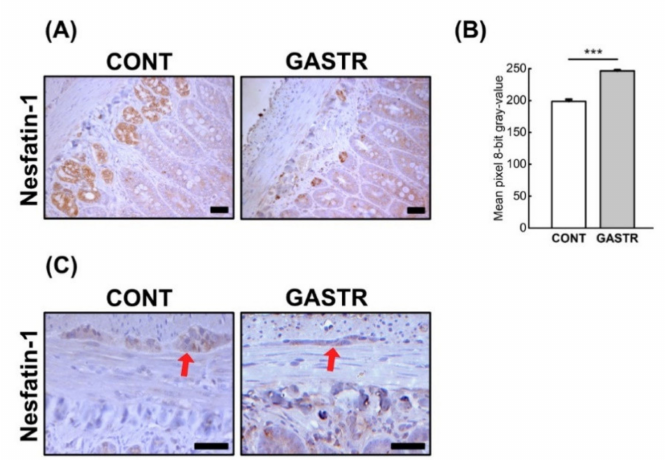
Figure 5. ( A ) Representative photomicrographs of the immunohistochemical reactions for nesfatin-1 in the jejunal crypts and ( C ) the Auerbach plexus (red arrow). Sections were developed in 3,3 (cid:48) - diaminobenzidine tetrahydrochloride (DAB); counterstaining was performed with Mayer’s hema- toxylin. All the scale bars represent 50 µ m. ( B ) The intensity of expression of nesfatin-1 in the jejunum, measured by the quantitative assessment of mean pixel intensity values in the photomicrographs converted to 8-bit grayscale images. Scale from 0 (white pixel) to 255 (black pixel); the lower the pixel value, the higher the intensity of immunohistochemical reaction. Graph shows mean ± stan- dard error. Significance was established using a two-tailed Student’s t -test (normally distributed data), Welch’s test (normally distributed data with unequal variances) or the Mann–Whitney test (for pairwise comparisons with at least one non-normally distributed dataset); *** p < 0.001.